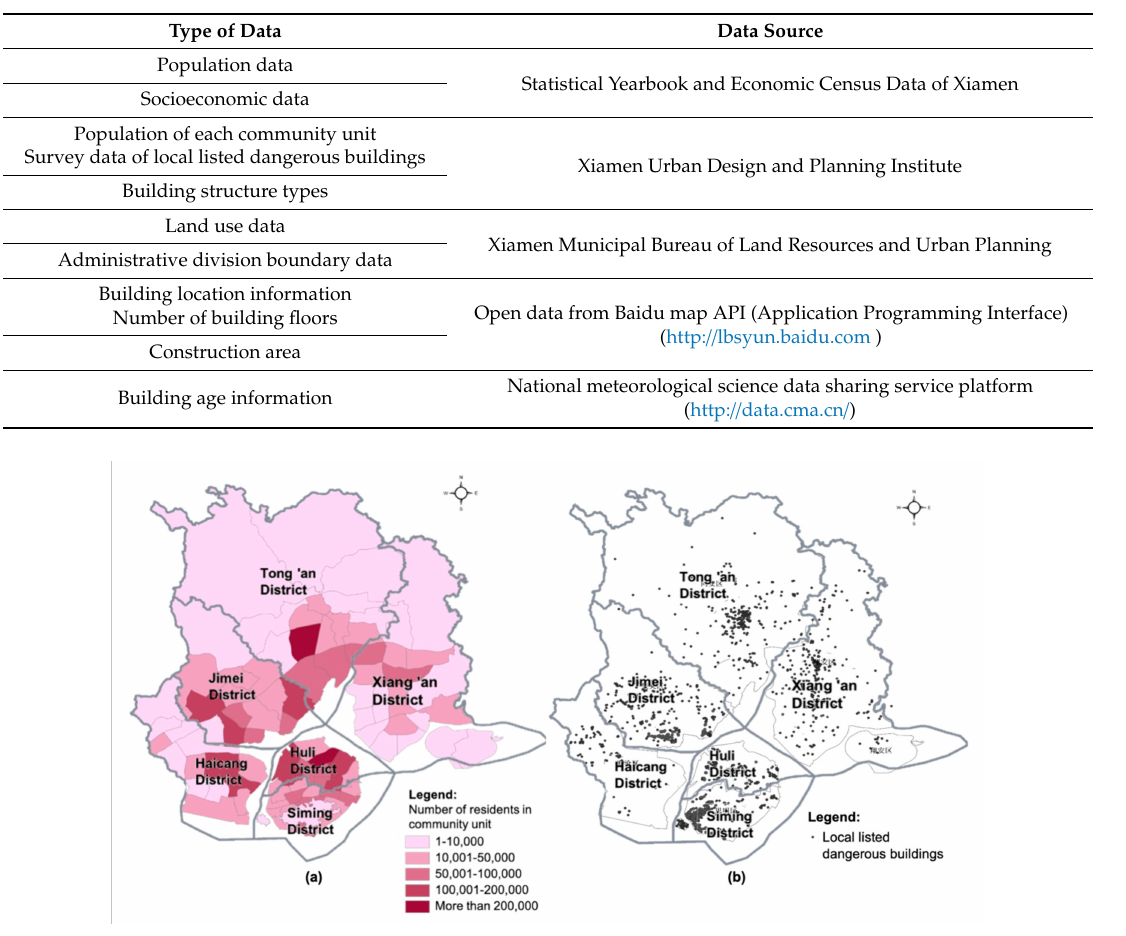
Table 1. Type of data and Sources.